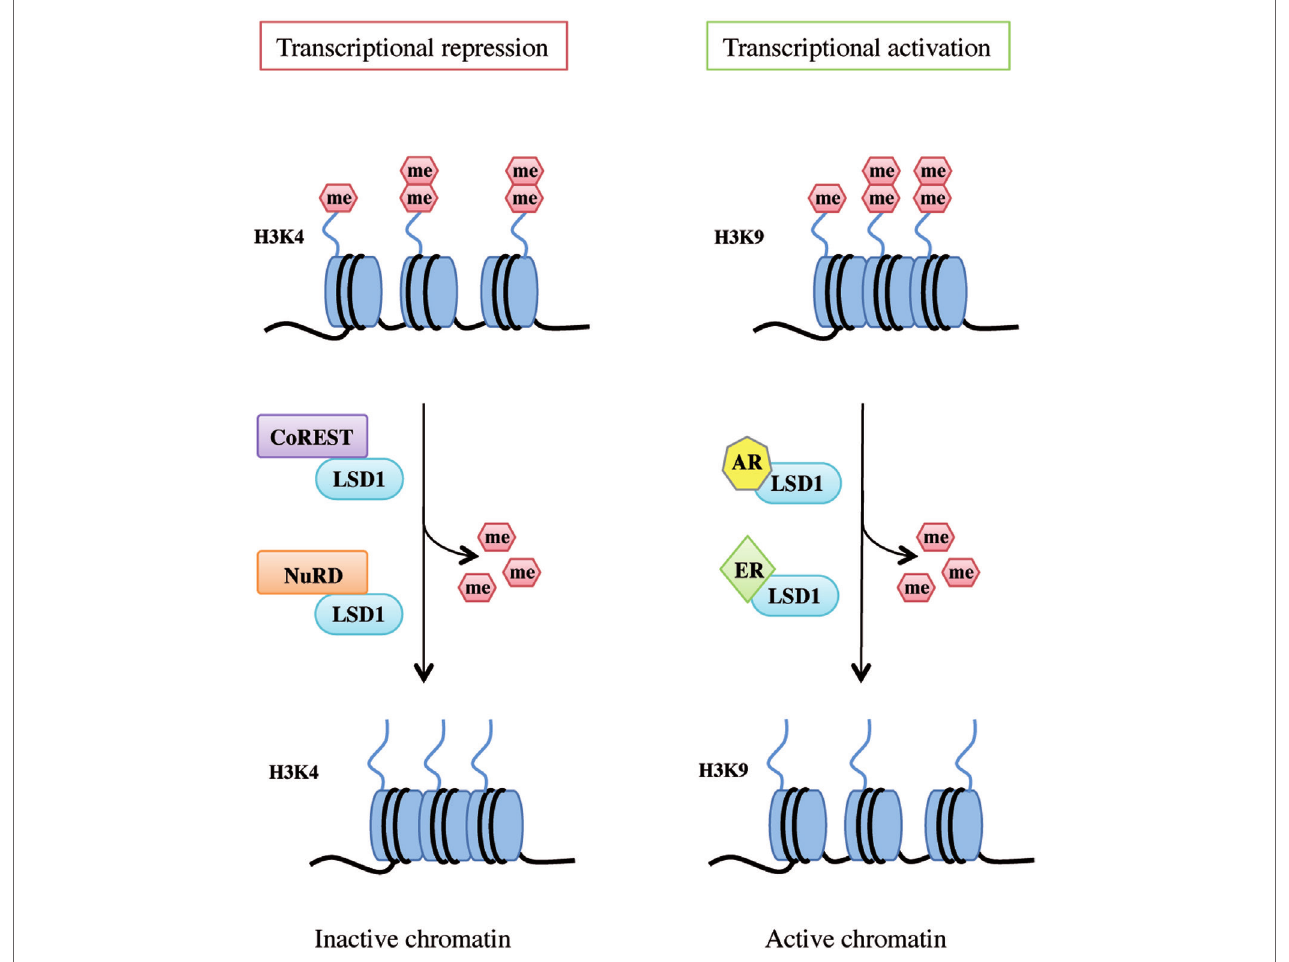
FigURe 2 | Lysine-specific demethylase 1A (LSD1) dual functions as transcriptional repressor and activator. LSD1 regulates chromatin accessibility through its demethylating activity on histone H3 Lys4 and Lys9 residues. On the left, LSD1 binds to the CoREST or nucleosome remodeling and deacetylase repressive complex thus demethylating mono- and dimethyl-group on histone H3K4 and allowing genes transcriptional repression. On the right, following androgen receptor or estrogen receptor binding, LSD1 promotes transcriptional activation by demethylating mono- and dimethyl-group on histone